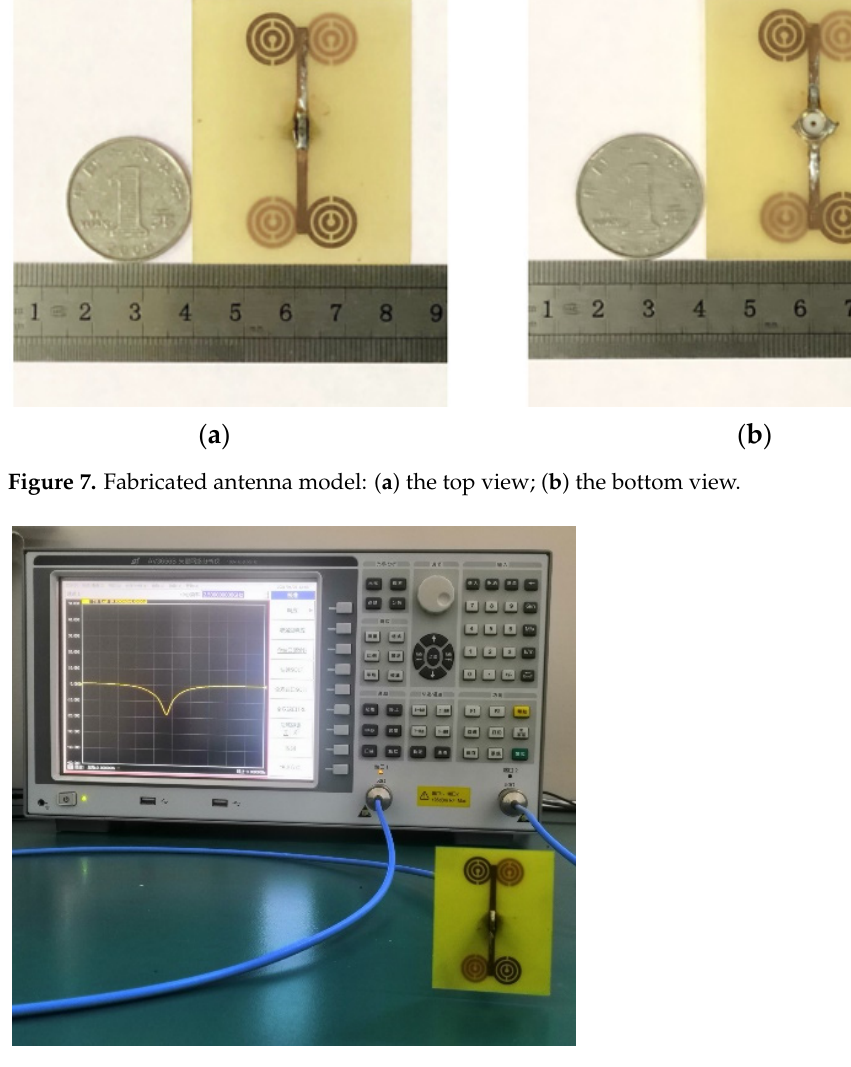
Figure 8. Experimental setup.